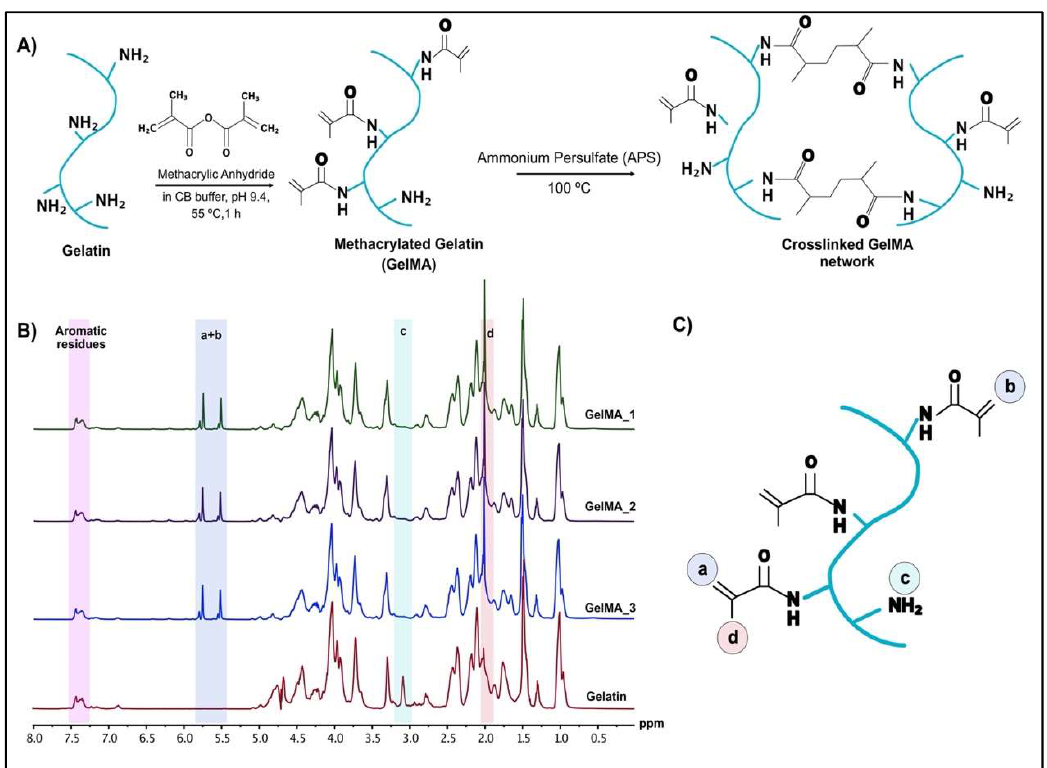
Figure 2. Methacrylated gelatin synthesis and 1H-NMR spectra of gelatin and GelMA: ( A ) Reaction scheme of gelatin with methacrylic anhydride to form GelMA. ( B ) 1 H-NMR spectra of gelatin and three batches of GelMA (GelMA_1, GelMA_2 and GelMA_3) in DH 2 O. ( C ) Specific protons indicated on the 1H-NMR spectra are highlighted on the GelMA structure where: (a) and (b) indicate acrylic protons of methacrylamide groups in lysine and hydroxylysine residues, respectively; (c) indicates methylene protons of unreacted lysine; and (d) indicates methyl protons of methacrylamide